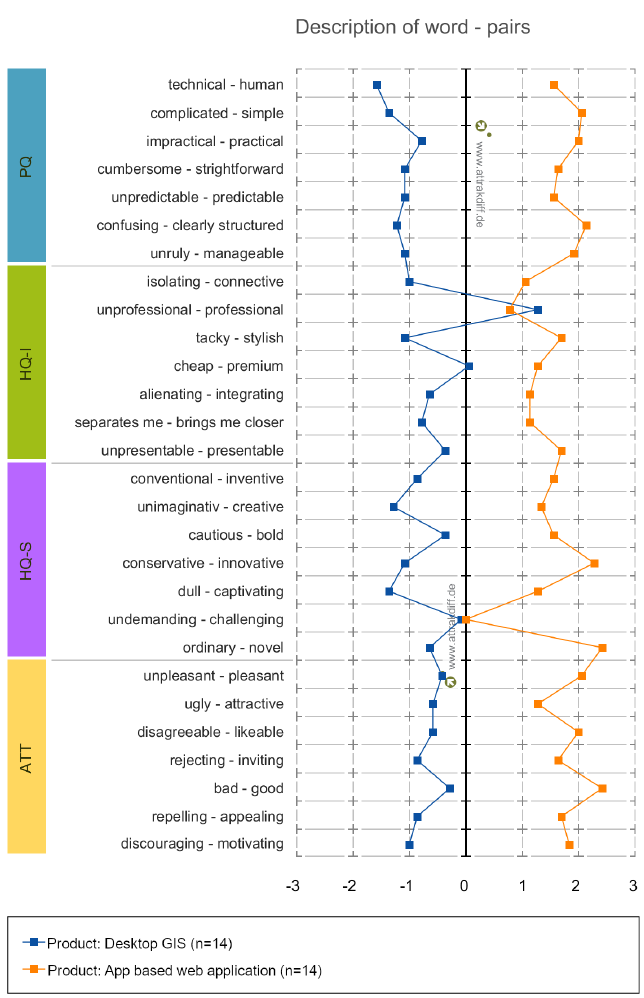
Figure 7. Result of UX-Measurement (Description of